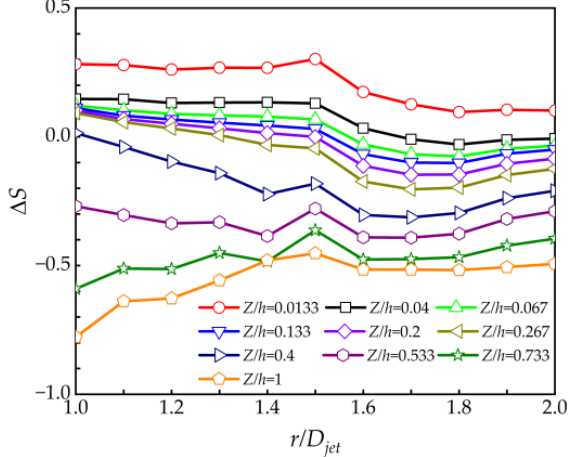
Figure 6. Hilltop speedup ratio at different radial positions.